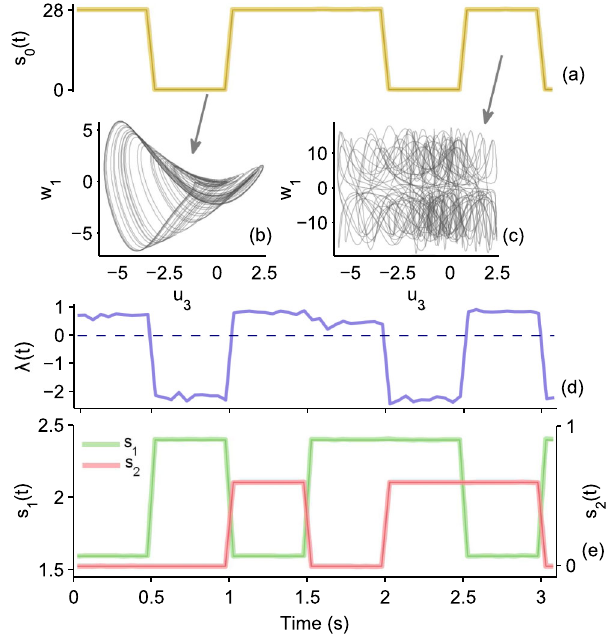
FIG. 2 The communication procedure based on coupled chaotic oscillators [Eqs. (5) and (6)]. (a) The transmitted binary signal s 0 ð t Þ acting as a ρ variable in the Lorenz oscillator. Lissajous curves qualitatively indicating the existence of generalized synchronization during (b) synchronized and (c) nonsynchronized intervals. The gray arrows point to syn- chronization intervals in the s 0 ð t Þ signal. (d) The largest Lyapunov exponent detected from the driven Lorenz oscillator serves as an index of time-evolving generalized synchronization. (e) Simultaneously transmitted signals s 1 ð t Þ and s 2 ð t Þ . For comparison, the original signals s 0 ð t Þ , s 1 ð t Þ , and s 2 ð t Þ are presented in dark color below the received ones shown in light transparent color in (a) and (e) — note that in some intervals they are